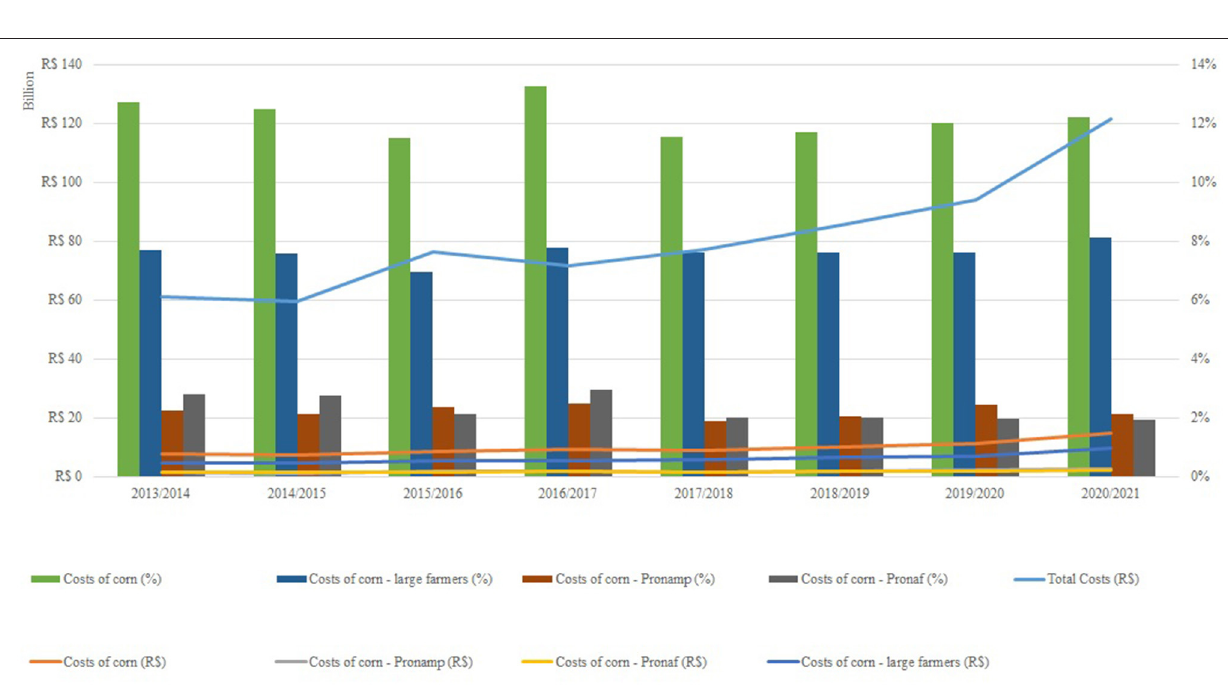
FIGURE 3 | Amounts and percentage of rural credit applied to total operating costs, total operating costs of corn, and operating costs applied to corn of large, medium and family farmers from 2013 to 2021. Source: Prepared by the authors with data from BCB